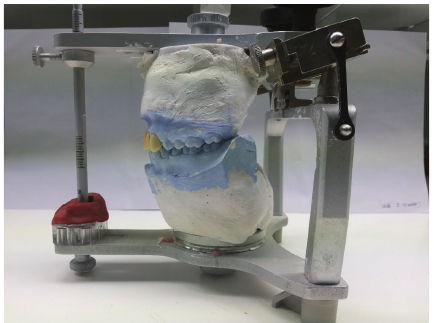
Figure 6: Customised incisal table made according to provisional restorations.